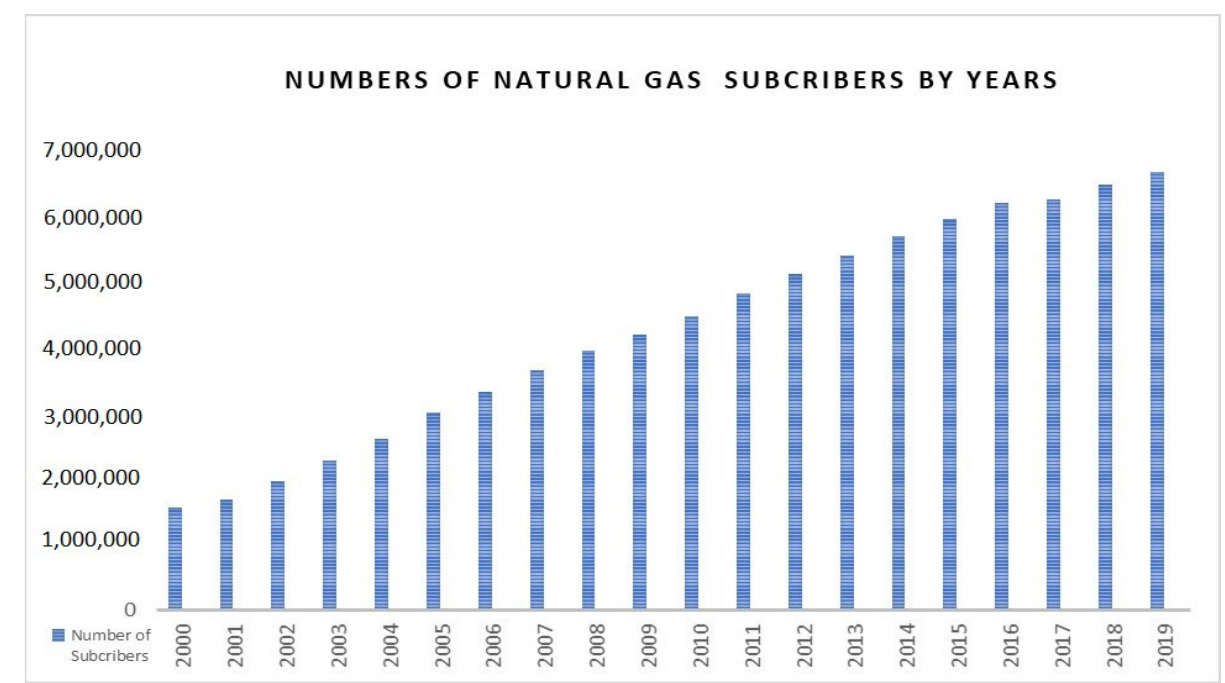
Figure 2. Number of natural gas subscribers by years in Istanbul.